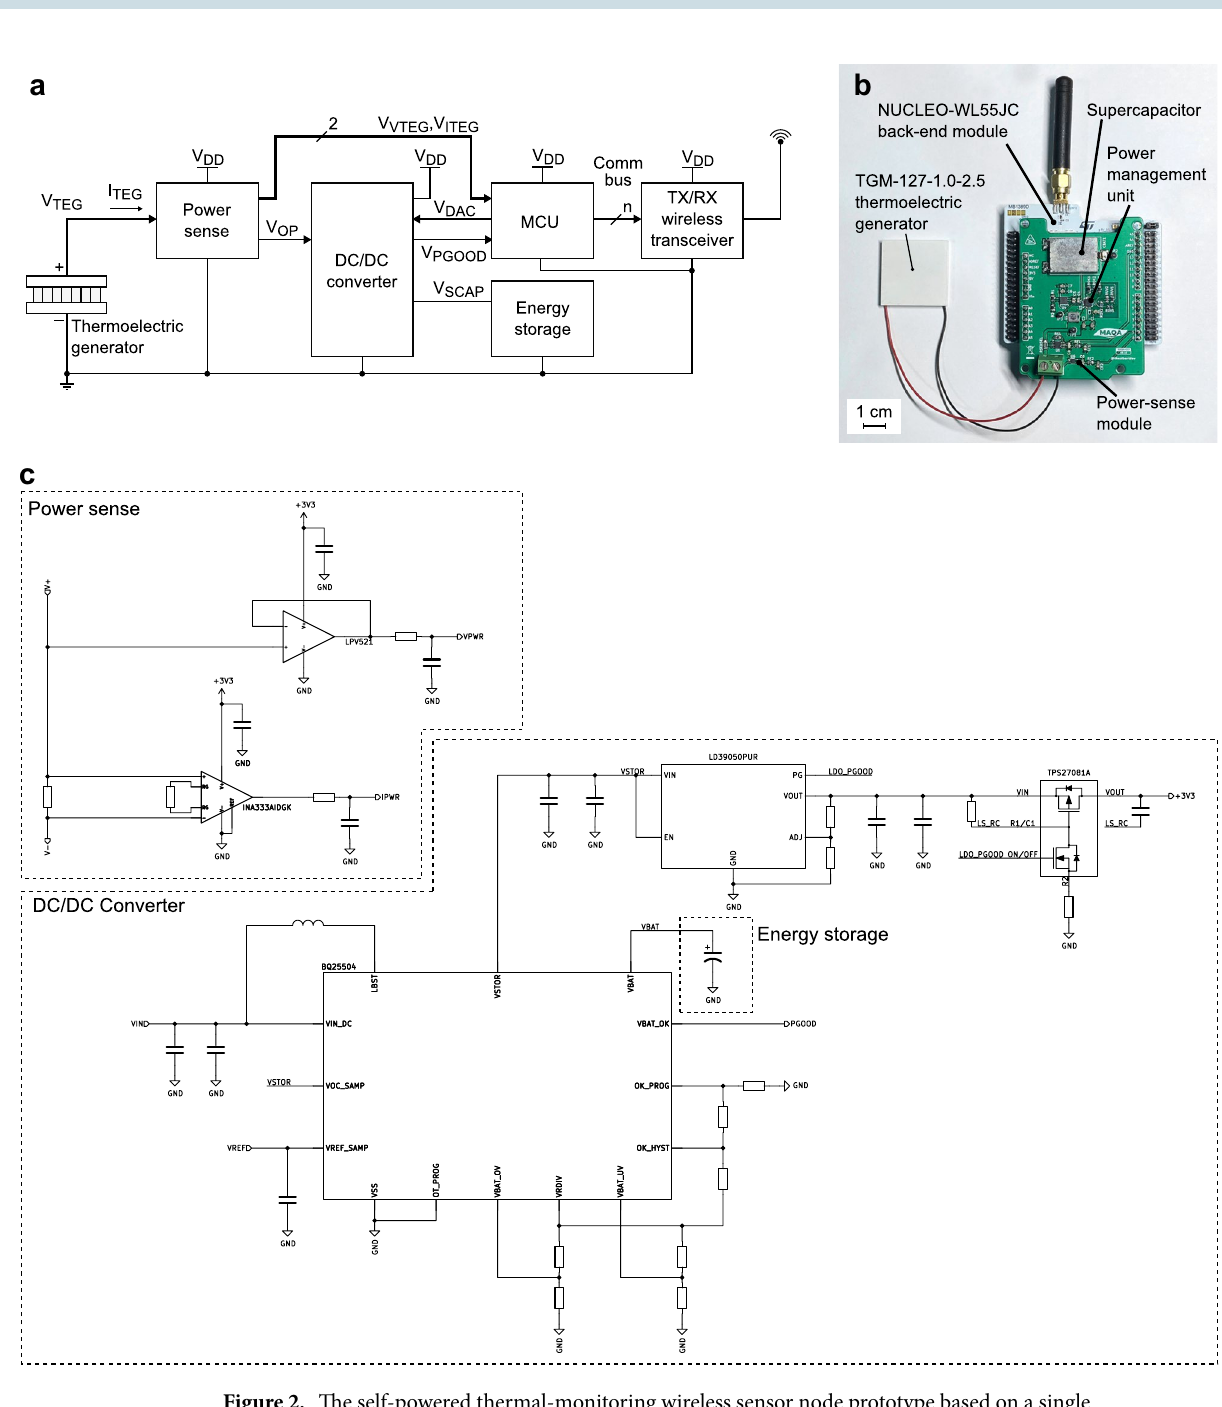
Figure 2. The self-powered thermal-monitoring wireless sensor node prototype based on a single thermoelectric generator. ( a ) Block diagram of the system architecture. ( b ) Photograph of device implementation. ( c ) Circuit diagram of the implemented